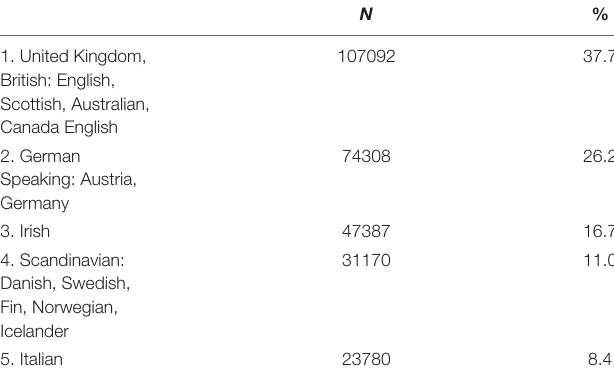
TABLE 3 | Ancestry substantially